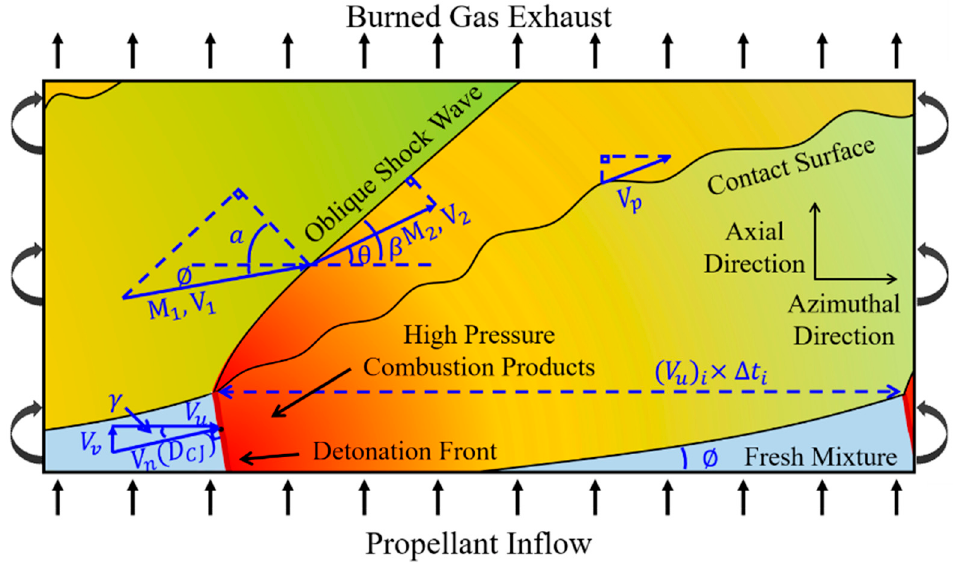
Figure 1. Schematics of flow field in an RDE based on the standing detonation.